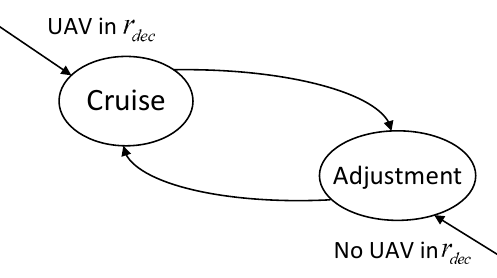
Figure 4. Reference distance of UAV.